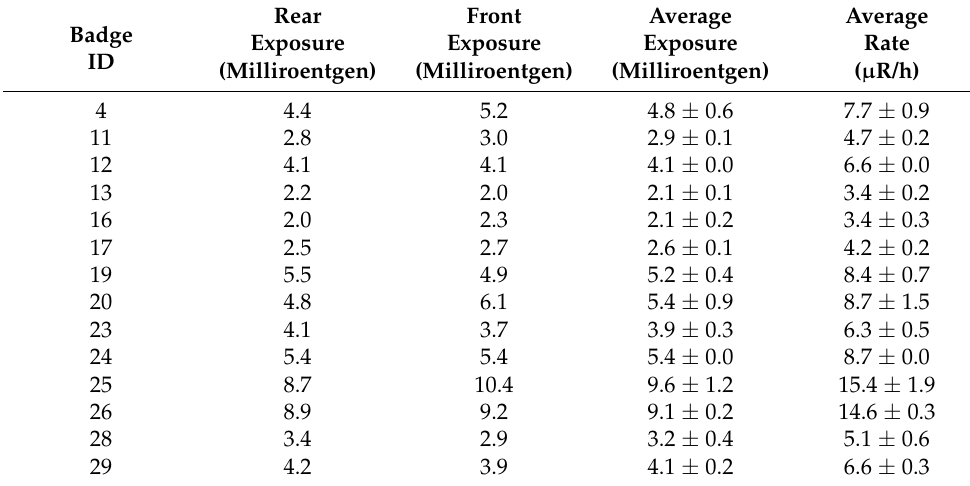
Table 1. The measurement results from integrating passive detectors, such as TLDs, for ultra-low- level ambient dose and dose rate at the surface of water shielding at the DEAP-3600 detector (except TLDs with badge IDs 25 and 26, which were placed next to the fire door; see Figure 2). TLD detectors that were inside badge ID 28 were placed on the deck of Cube Hall. TLD detectors located inside badge 29 were placed on top of the water shielding of the DEAP-3600 detector. Average Average Front Rear Badge Rate Exposure Exposure Exposure ID ( µ R/h) (Milliroentgen) (Milliroentgen) (Milliroentgen)